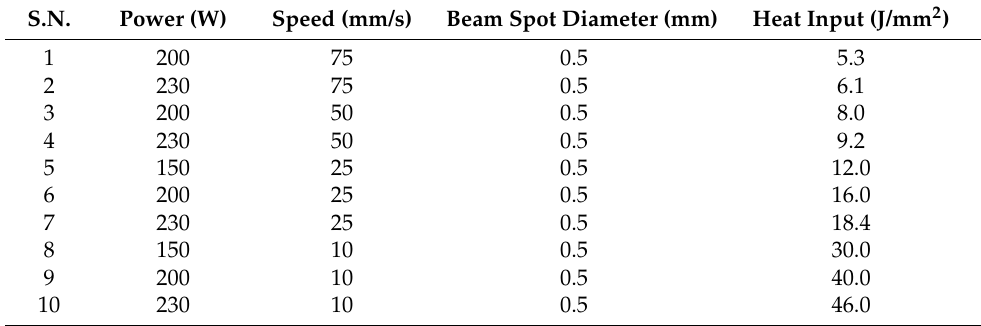
Table 2. Parameters used for laser surface hardening experiments.